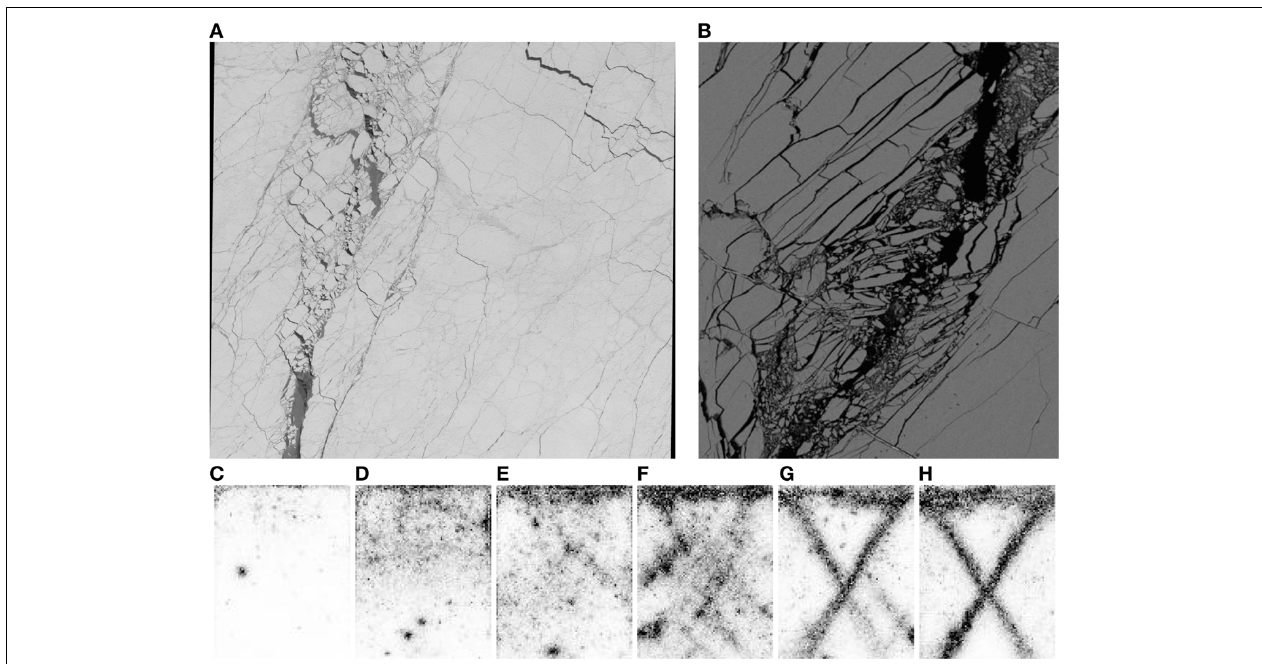
FIGURE 1 | Fracture patterns. (A) Arctic sea ice cover; image size: 60km. (B) Granite thin section: a sample of height 80mm and diameter 40mm is deformed until rupture and the fracture is sheared over 2mm. Image size: 4 × 3mm 2 , i.e., 1024 × 888 pixels of 3.9 µ m. (C–H) Granular material: maps of correlation of the scattered light. White pixels